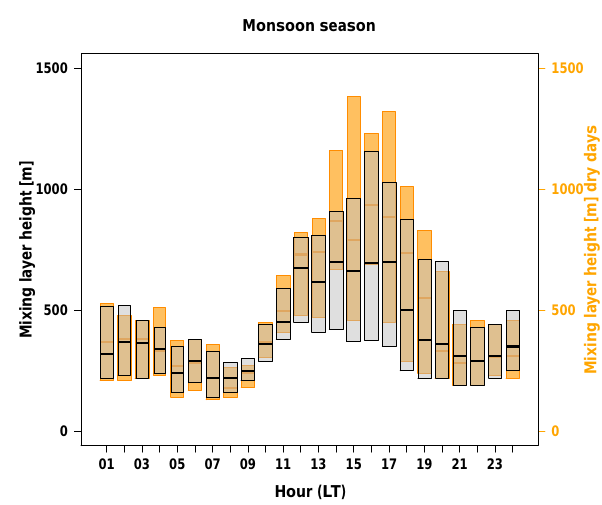
Figure 6. Diurnal cycle of the MLH with all days (grey) and only dry days (light orange) as a boxplot (showing the median, the upper and lower quantile) for the monsoon season (June–September 2013) at the Bode